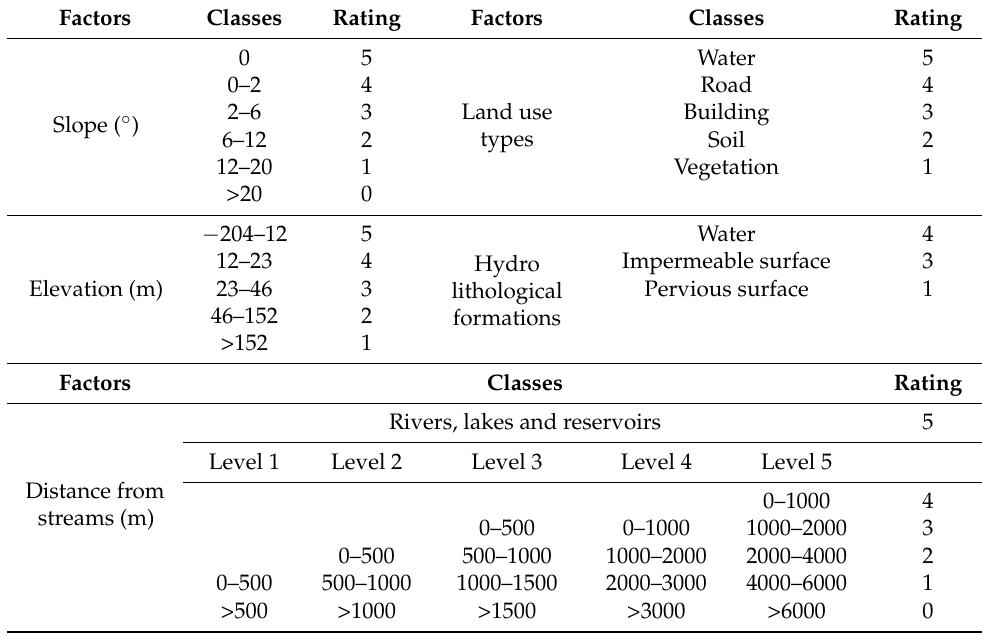
Table 3. The classes and rating of factors in flood hazard